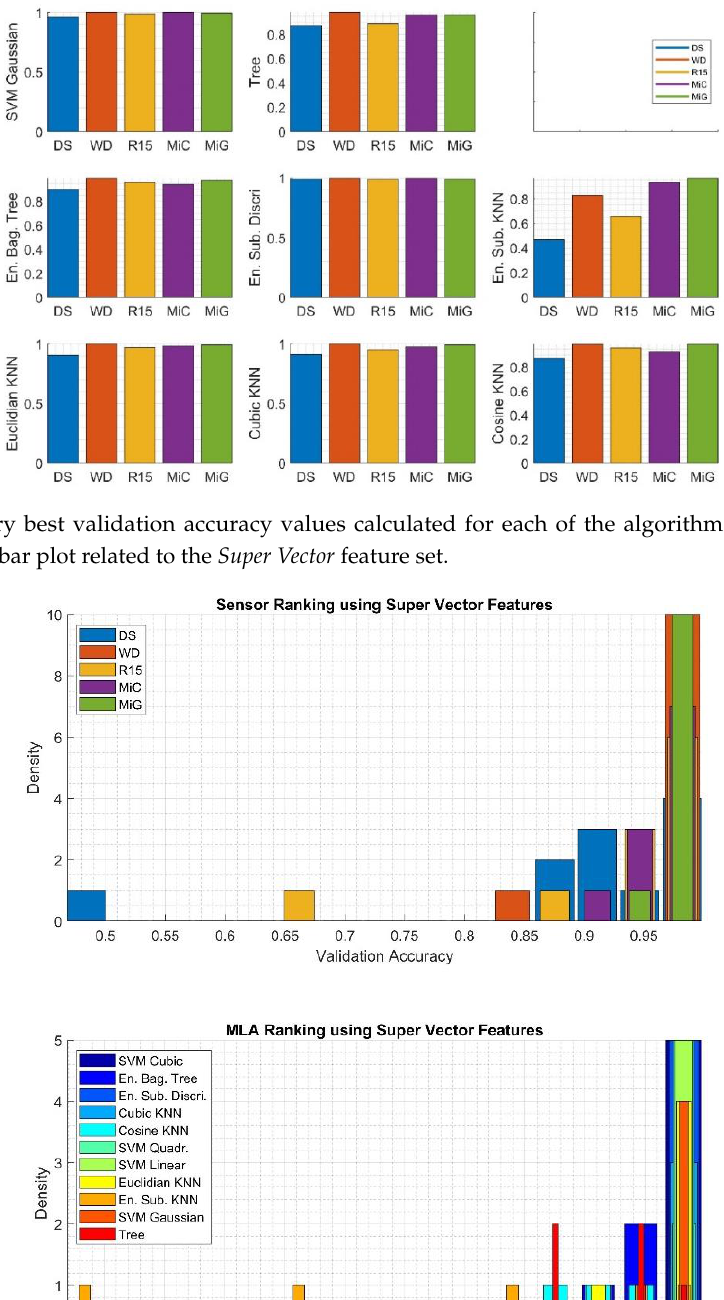
Figure 8. Results of analysis depicting quantities of the best sensor (upper) and the best machine learning algorithm (MLA) (bottom) applied for classification using the Super Vector feature determined using validation accuracy value.